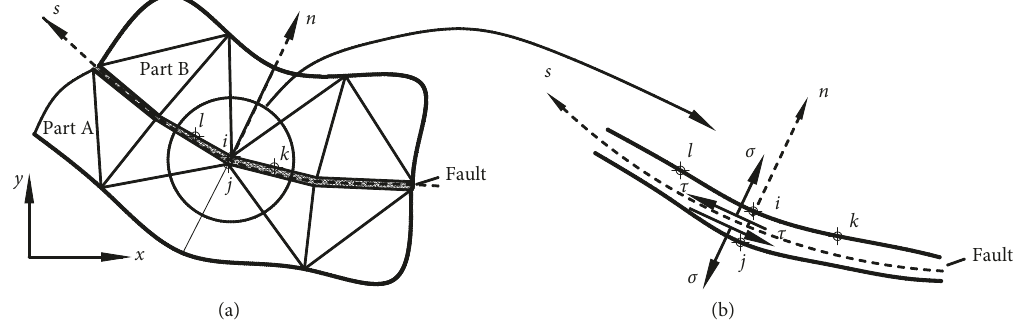
Figure 2: COJO element along the interface between two rock parts.